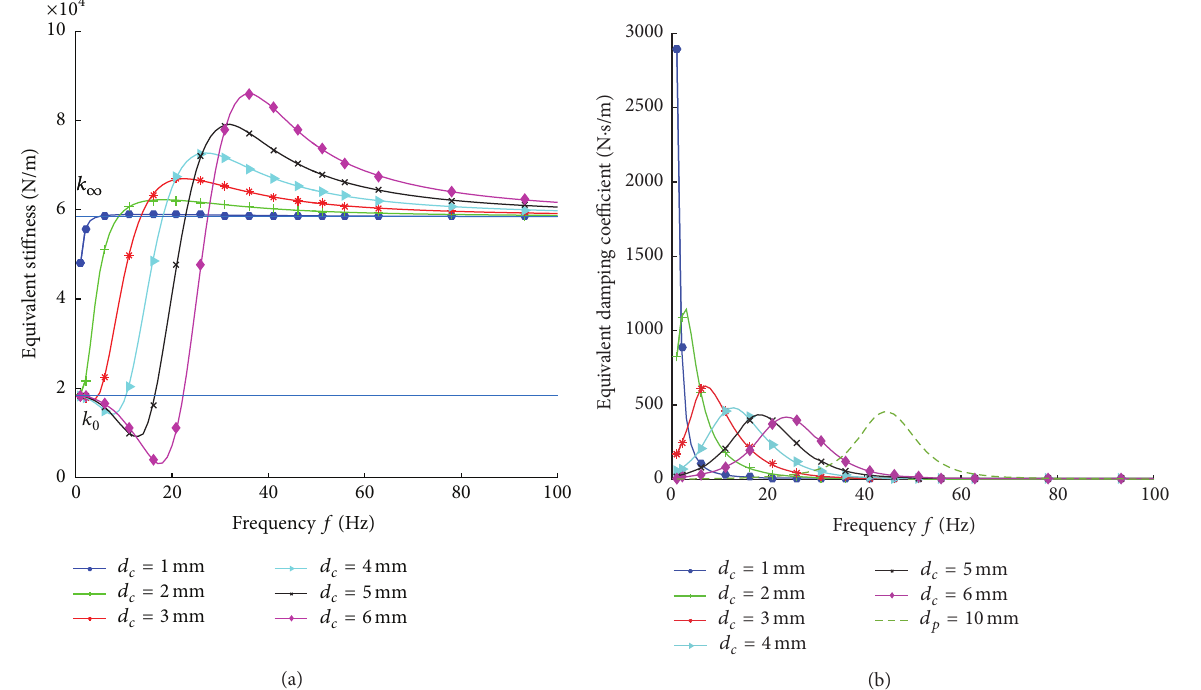
Figure 9: (a) Equivalent stiffness under different 𝑑 𝑐 values. (b) Equivalent damping coefficient under different 𝑑 𝑐 values.